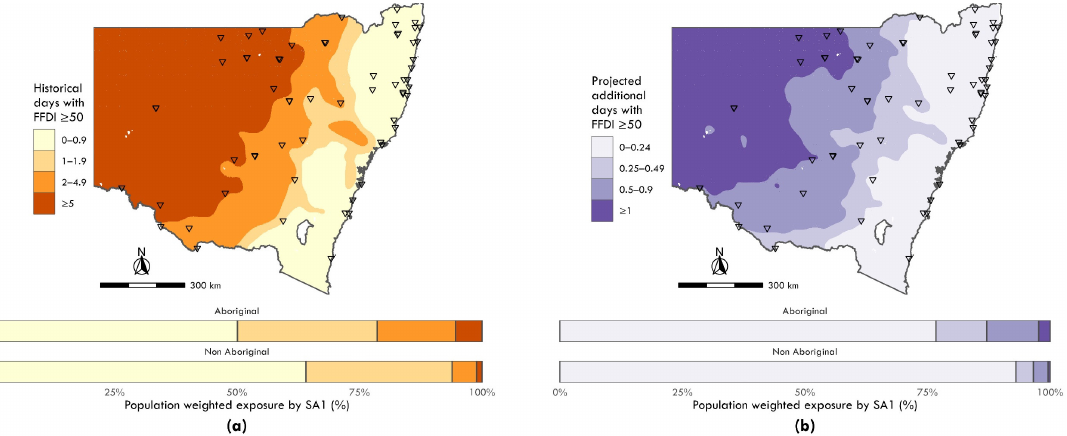
Figure 3. Maps of annual days with Macarthur Forest Fire Danger Index exceeding 50 (i.e., “severe” fire danger), with bar charts indicating relative exposure by category across Aboriginal and